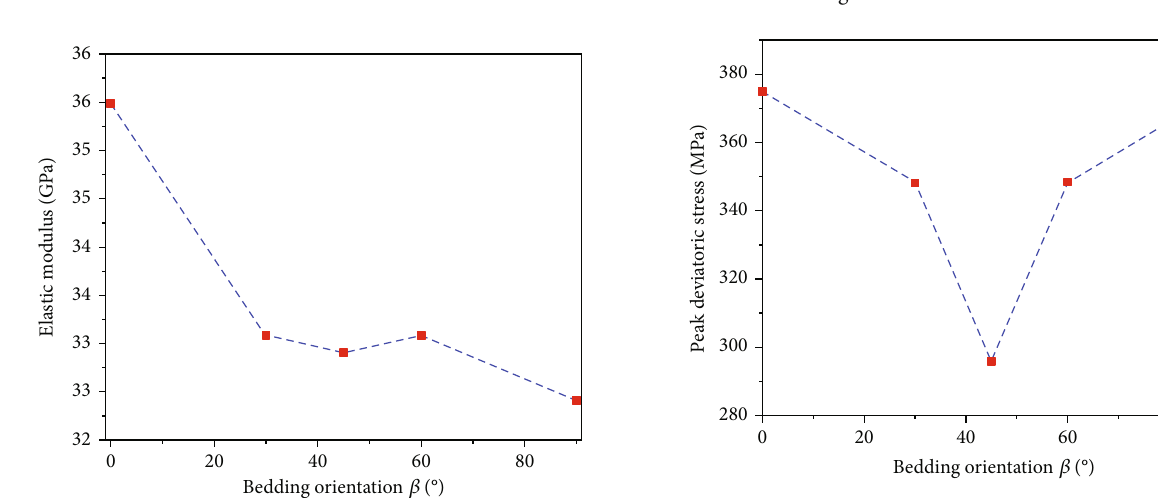
Figure 6: Stress-strain curves of cores with di ff erent bedding orientations.